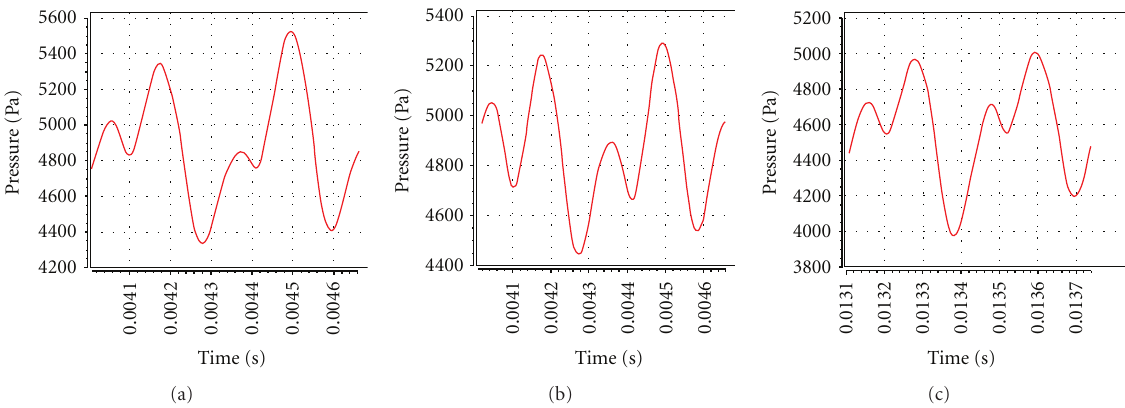
Figure 17: Pressure at a fixed point located at the casing wall for (a) 0.5 mm, (b) 1.0 mm, and (c) 1.5 mm gap.